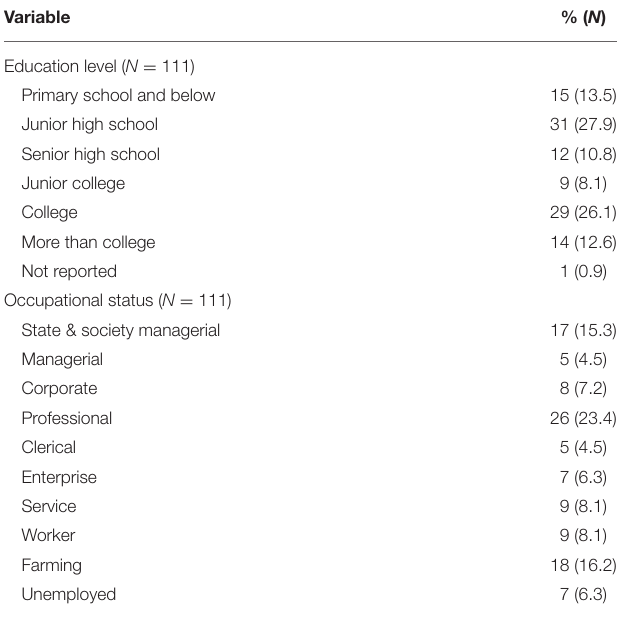
TABLE 1 | Sociodemographic data of